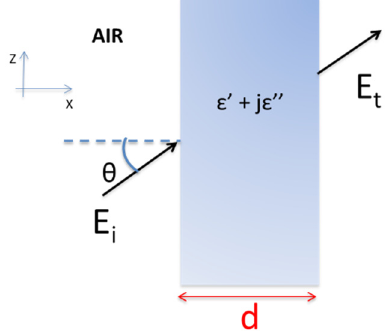
Figure 2. Shielding effectiveness of a dielectric slab to a uniform plane wave.